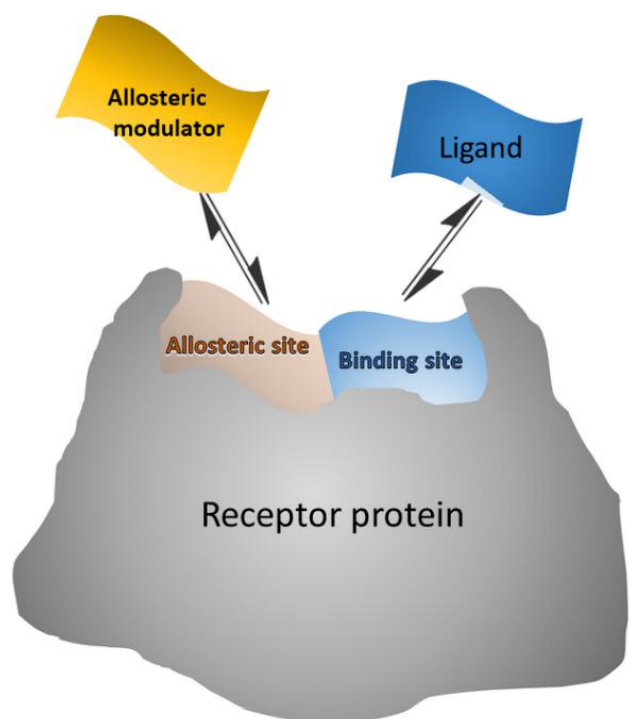
Scheme 3. Schematic representation of allosteric modulator/receptor and orthosteric